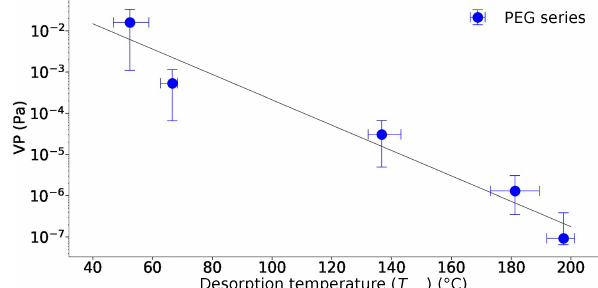
Figure 4. Reported vapour pressure measurements of the PEG se- ries (4–8) and associated T max values extracted from the UMan FIGAERO-CIMS. Errors on the y axis are those reported in the Krieger et al. (2018) study. Errors in the T max ( x axis) are the max- imum variation seen within the four thermograms from which the mean value was derived.